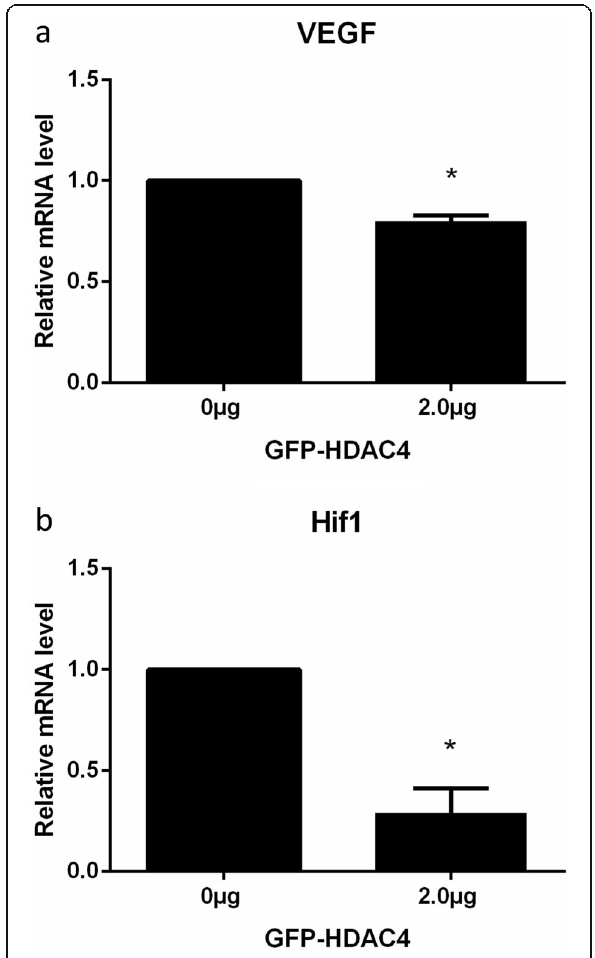
Fig. 6 mRNA levels of VEFG and Hif1 α following HDAC4 overexpression. a , b mRNA levels of Hif1 α and VEGF were detected in RT-qPCR following the transfection of 2.0 μ g GFP-HDAC4 into isolated murine chondrocytes. The accompanying bar graphs present the average relative mRNA values for VEGF and Hif1 α , respectively, from three independent experiments. Data are expressed as mean ± SEM. * P < 0.05 vs. vehicle group